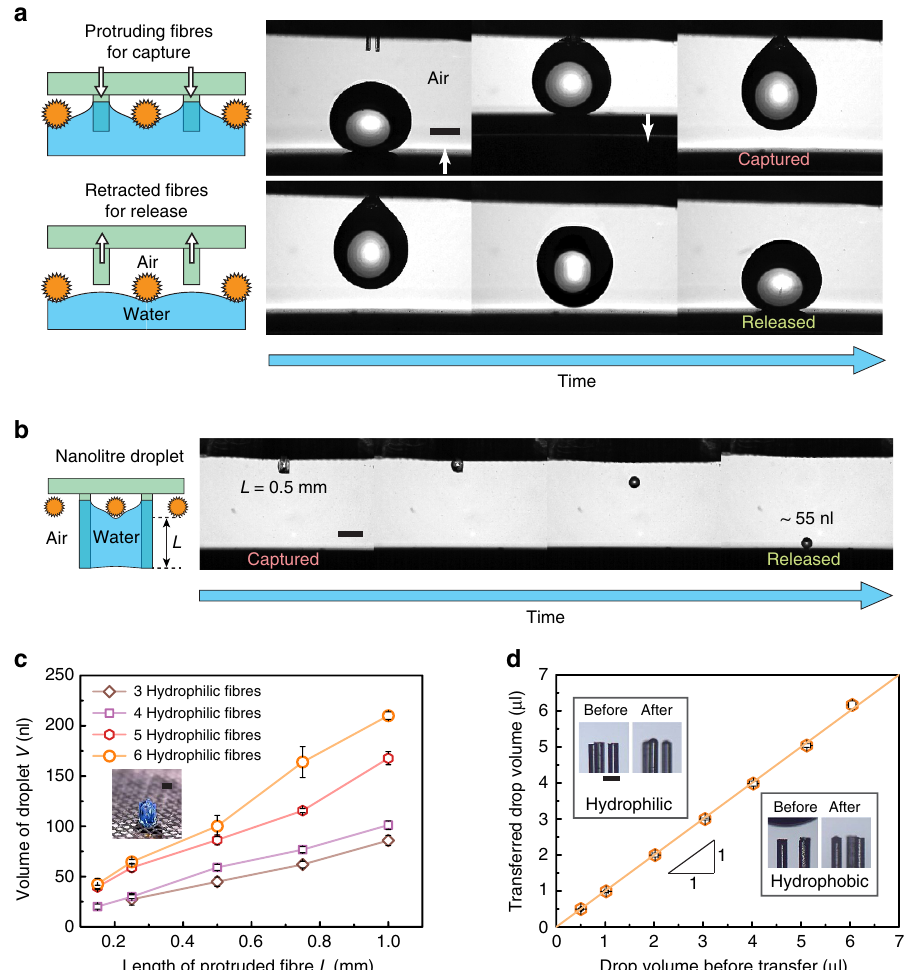
Figure 3 | The manipulation of aqueous droplets in air using an MRS. Schematic illustrations and time-sequence images showing the capture and complete release of water droplets of ( a ) 10 m l and ( b ) 55nl onto a superhydrophobic substrate in air. Scale bar, 1mm. ( c ) The volume of the water droplet prepared using a hydrophilic-fibre MRS increases as the protrusion length of the fibres increases. The inset presents an optical micrograph showing a stained water column trapped by four hydrophilic fibres. Scale bar, 300 m m. The error bars indicate the standard deviations over five independent measurements. ( d ) The drop volume remains the same before and after transfer using a 4-hydrophilic-fibre MRS. The insets present optical microscopy images showing almost no water residue on the regulating fibres after the transfer process. Scale bar, 200 m m. The error bars indicate the standard deviations over five independent